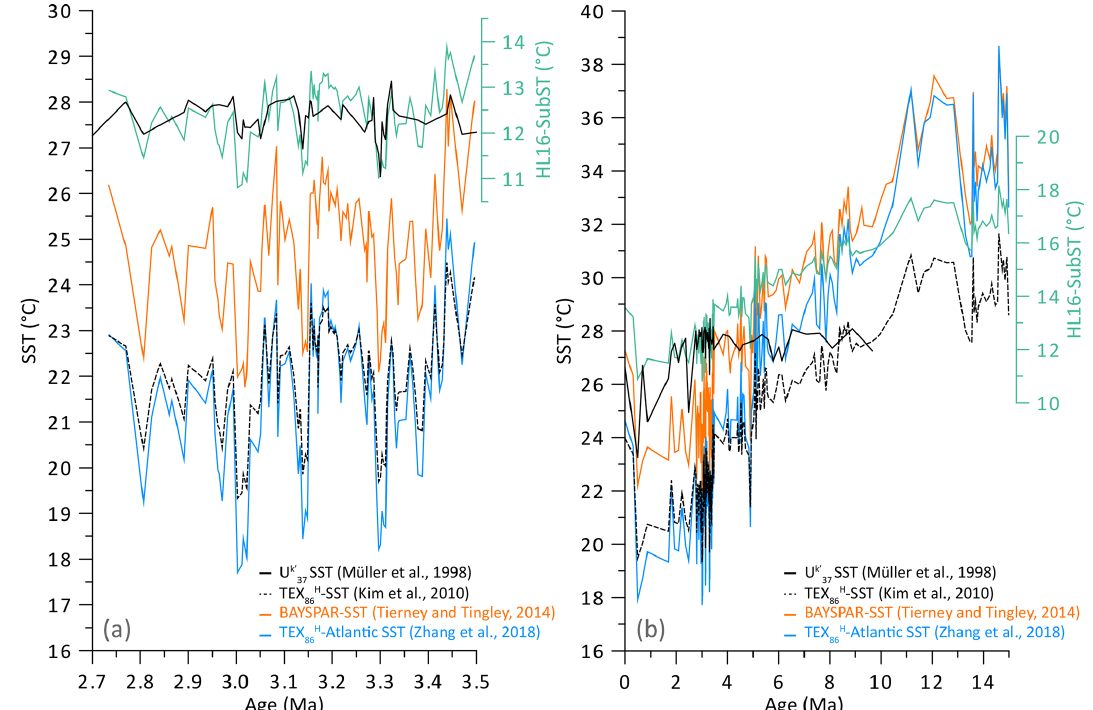
and alternative SST calibrations and with the HL16-SubST calibration (Ho and Figure 2. Site 959 TEX 86 record, calibrated using TEX H 86 Laepple, 2015), compared to the U k (cid:48) record. Late Pliocene glacial–interglacial variability in panel (a) and 15Myr evolution in panel (b) 37